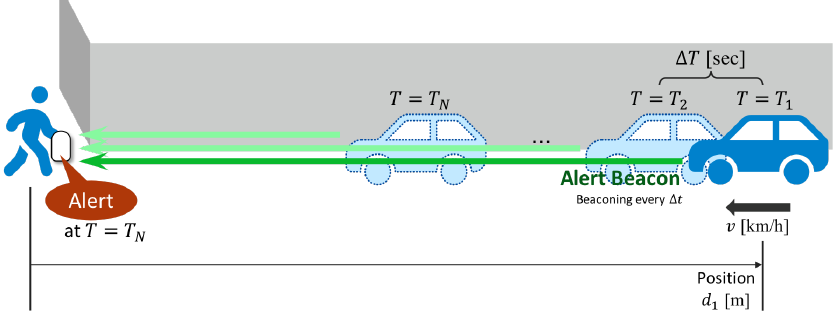
Figure 1. A system model of the proposed vehicle-approach detection technique.